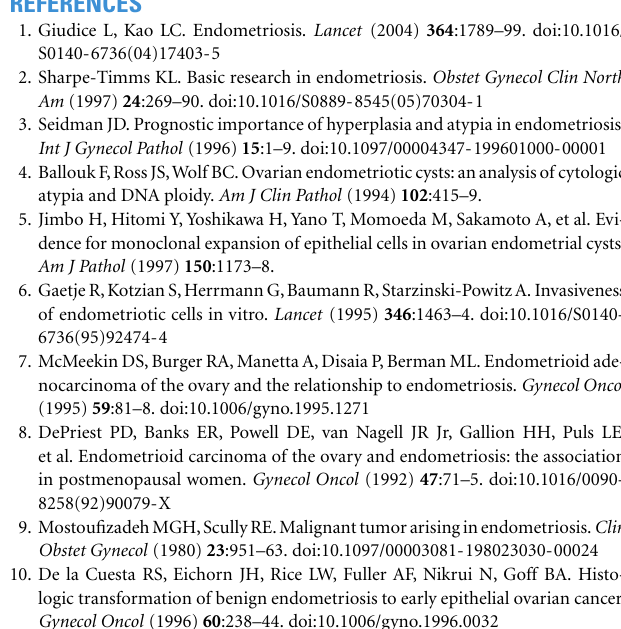
Jean Marc Bernard Ayoubi were involved in samples prepa- ration and analysis. Jean Gogusev was involved in manu- script preparation and performed the image and statistical data